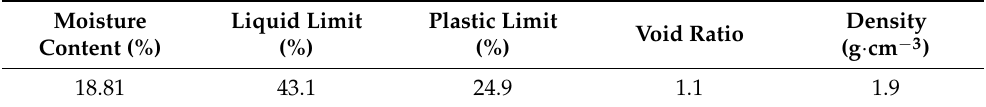
Table 1. In situ properties of shield mud.